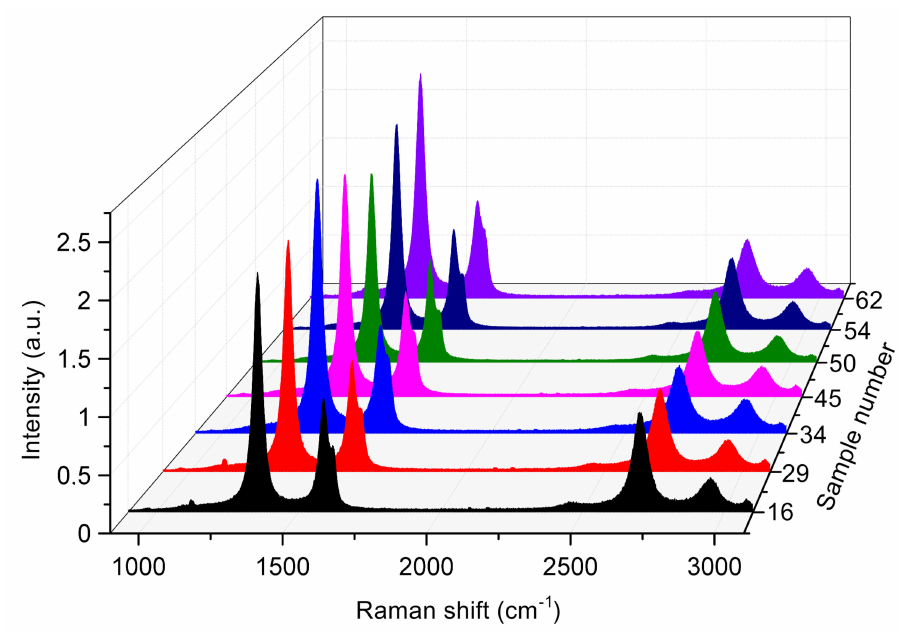
Figure 4. Raman spectra of vertical graphene for individual samples. Table 2. Ratios of Individual Raman Peaks Studied in Vertical